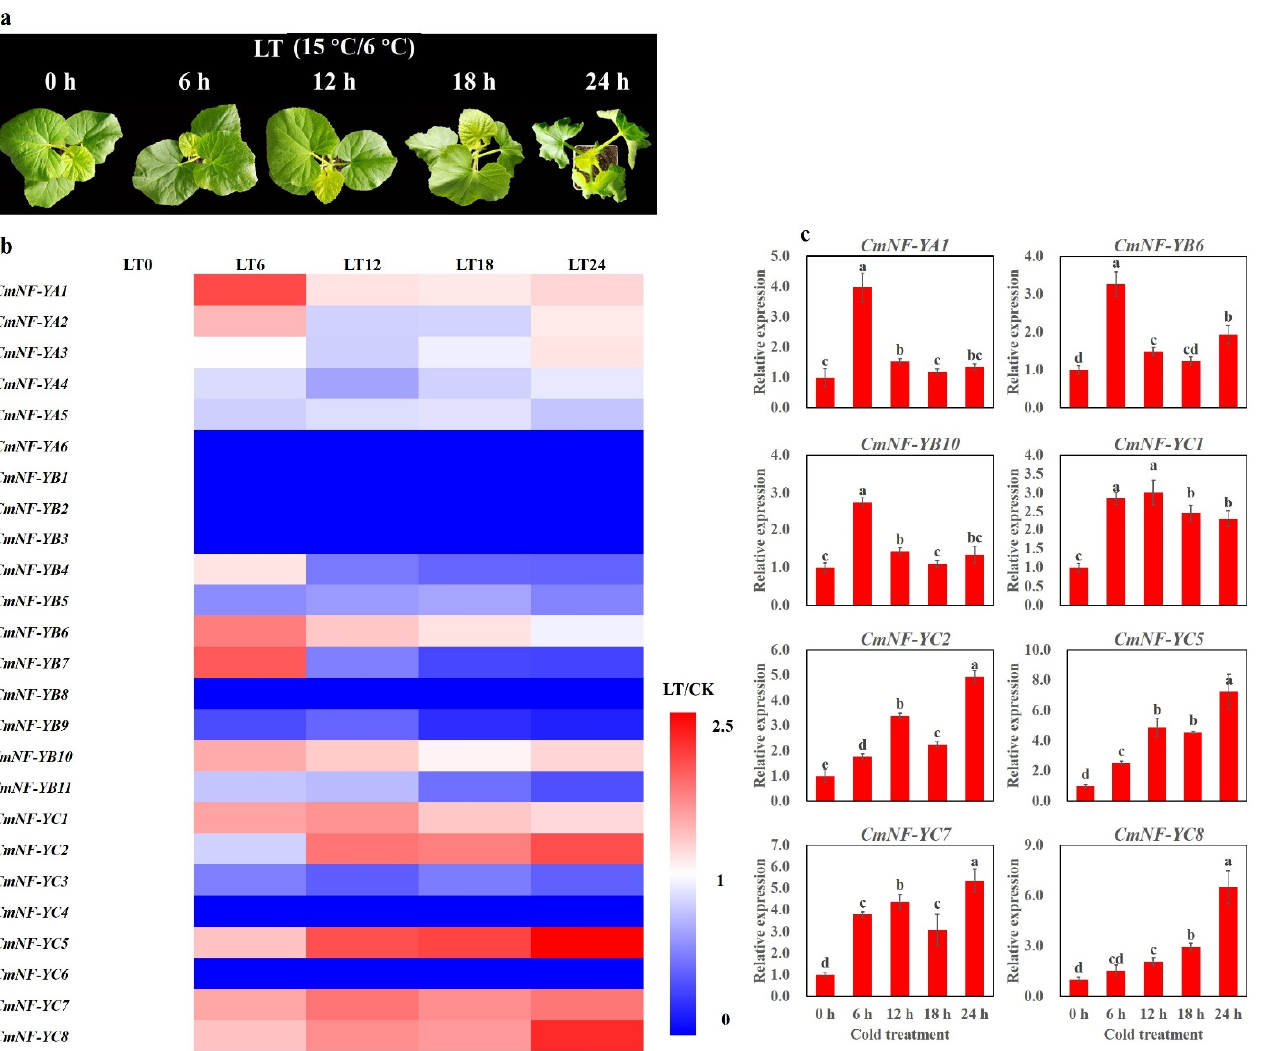
Figure 8. Expression profiles of CmNF-Ys under cold stress. The seedlings were exposed to cold stress (15 °C/6 °C, day/night, LT) for 24 h. The third true leaves were sampled for RNA-Seq and qRT-PCR after 0, 6, 12, 18, and 24 h cold treatment. We calculated the relative value before and after cold treatment (LT/CK) and converted the data into log 2 to draw the heat map. Error bars indicate the standard error of the mean. A one-way ANOVA was performed using Duncan’s multiple-range test. Di ff erent lowercase le tt ers represent signi fi cant di ff erences at the 0.05 level.